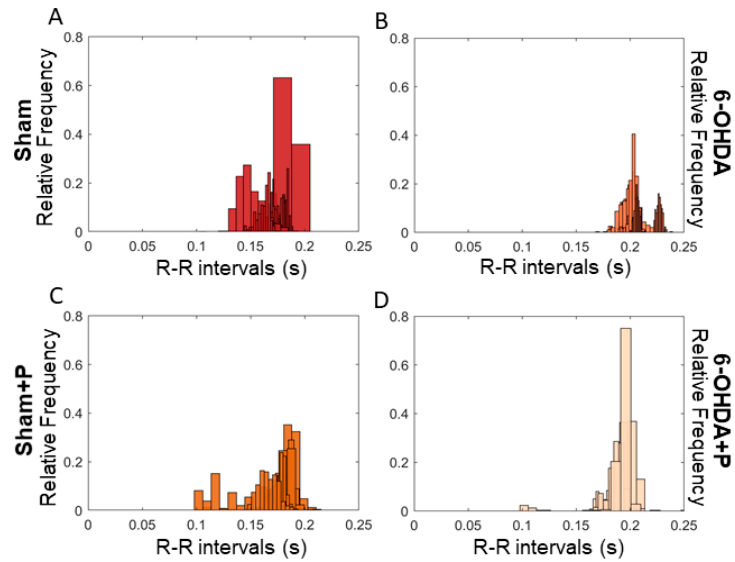
Figure 6. Histograms showing distribution of R-R intervals by length range. ( A ) sham: RR interval from 0.12 to 0.206 s; ( B ) 6-OHDA: RR interval from 0.175 to 0.237 s; ( C ) sham + P: RR interval from 0.095 to 0.212 s; ( D ) 6-OHDA + P: interval RR of 0.15 to 0.212 s. Table 1. Statistical moments of the distribution of the R-R intervals. Mean Standard